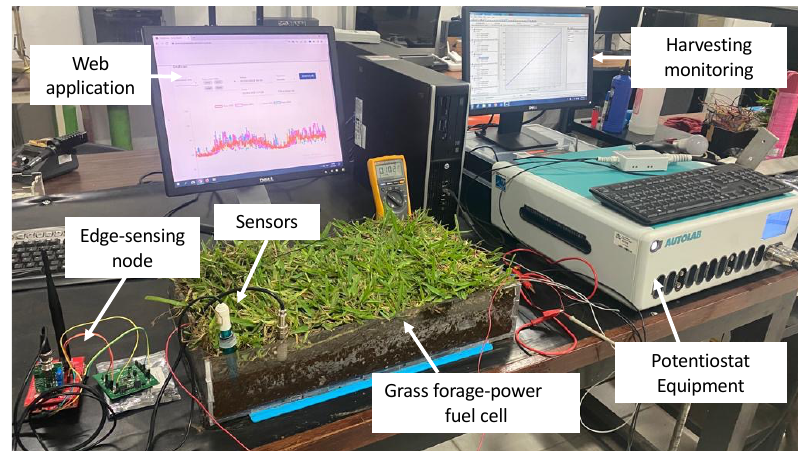
Figure 8. Prototype of the grass forage-power cell system.